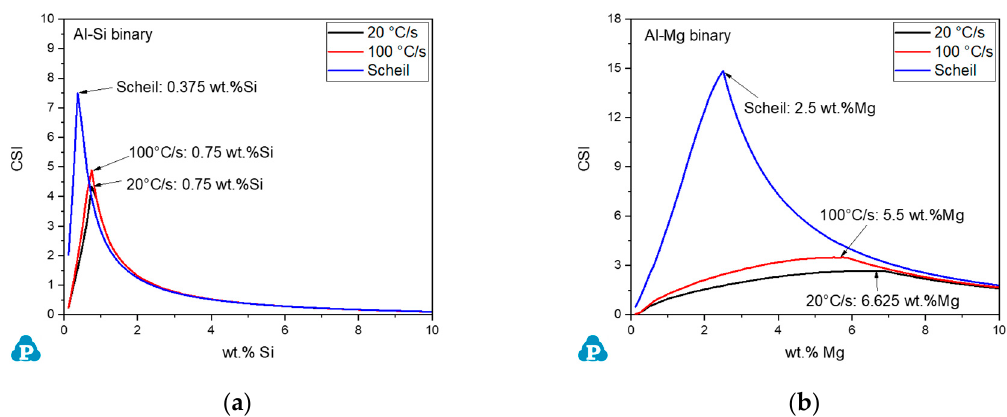
Figure 3. Calculated CSI values in the binary systems: ( a ) Al-Si alloys and ( b ) Al-Mg alloys.